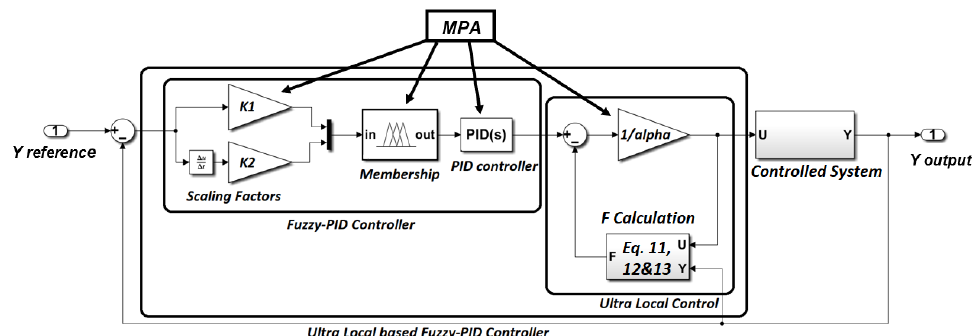
Figure 4. The MPA-based fuzzy PIDF Controller’s structure.